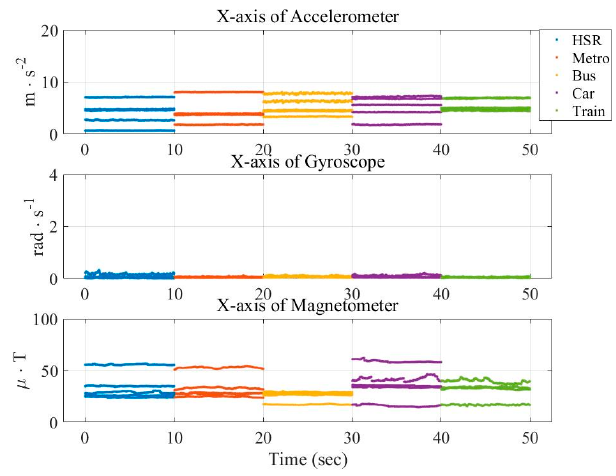
Figure 4. Distribution of averaged data from three sensors (x-axis) in the vehicular mode.